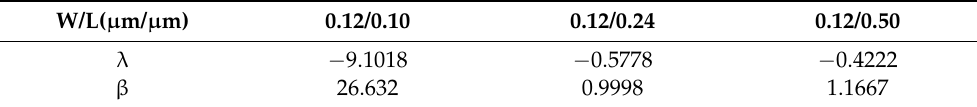
Table 2. Extracted parameters for λ and β values under V DS = 1.2 V and V GS – V T = 0.1~0.3 V with multi-fin.